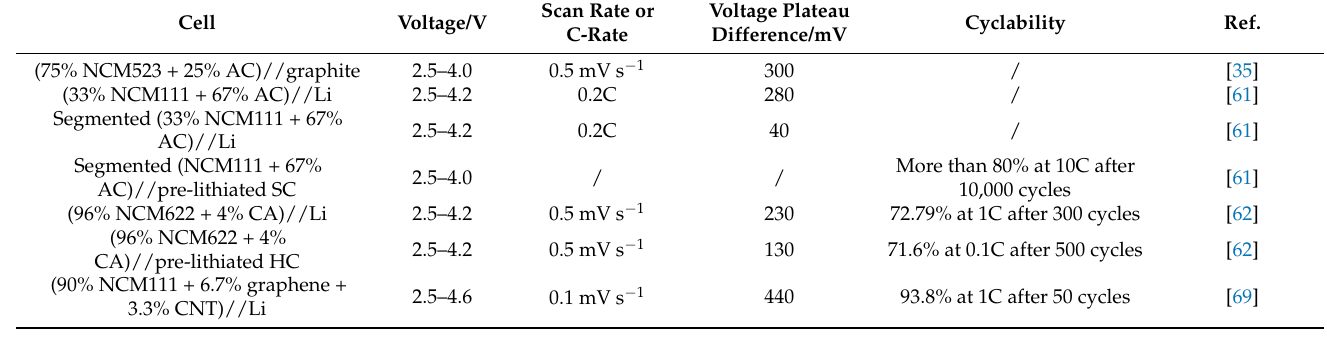
Table 1. Polarization phenomenon of selected NCM-based LIBCs.